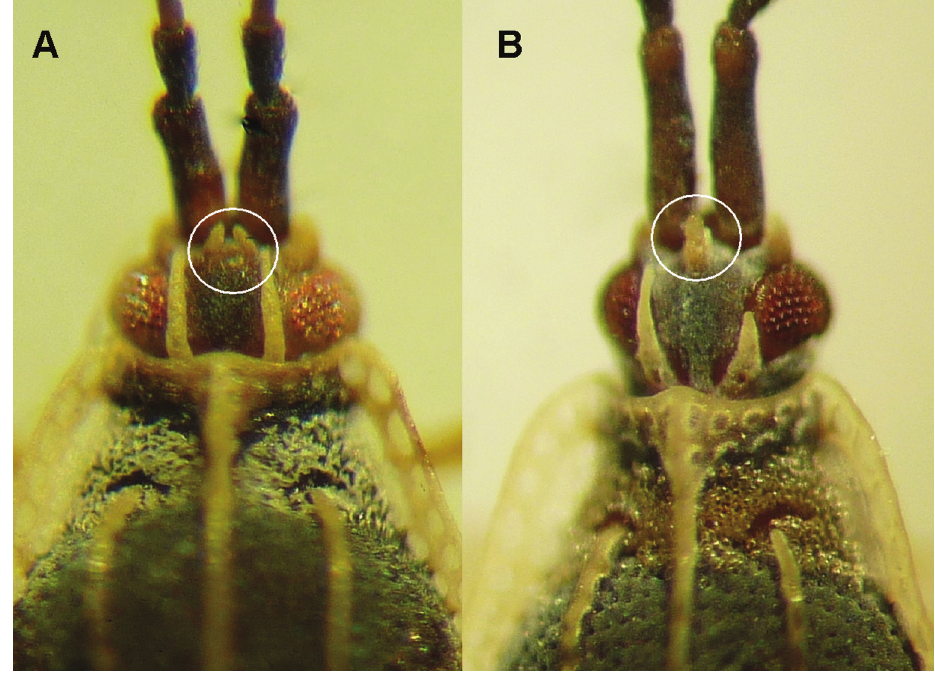
Fig. 1 - Dorsal view of lace bug species of cassava crops. Note the presence of small thorns at the anterior angle of the head near the antennas on Vatiga illudens (A) and a single central thorn in Vatiga manihotae (B)